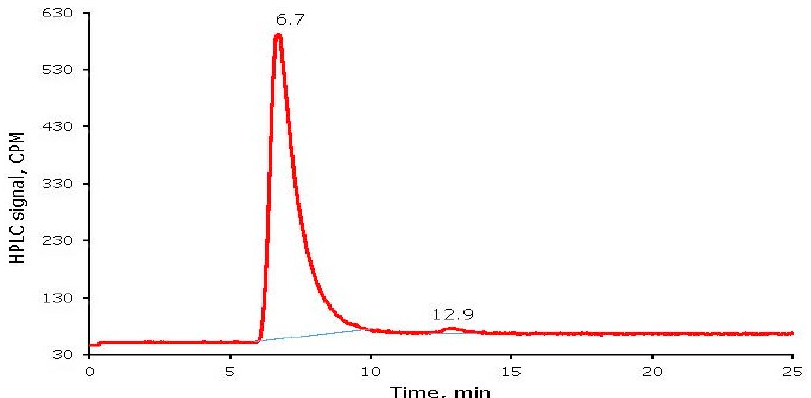
Figure 6. HPLC chromatogram of radioiodine labeled Bovine Serum Albumin (BSA).